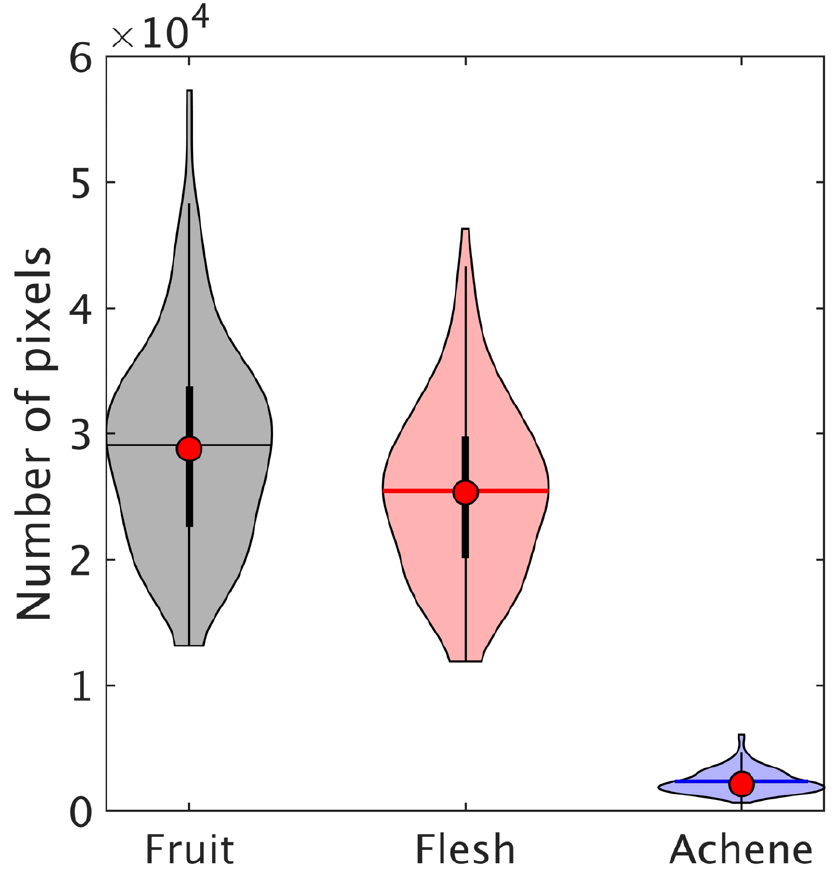
Figure 6. Number of pixels for ROI of fruit, flesh, and achene in strawberry, with ROIs defined by image masks created by preprocessing hyperspectral data.